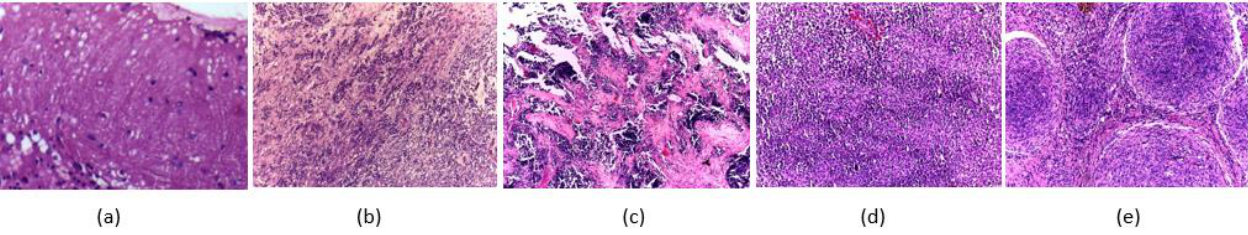
Figure 1. Samples of the childhood pediatric MB images: ( a ) normal, ( b ) classic, ( c ) desmoplastic, ( d ) large cell, ( e ) nodular.